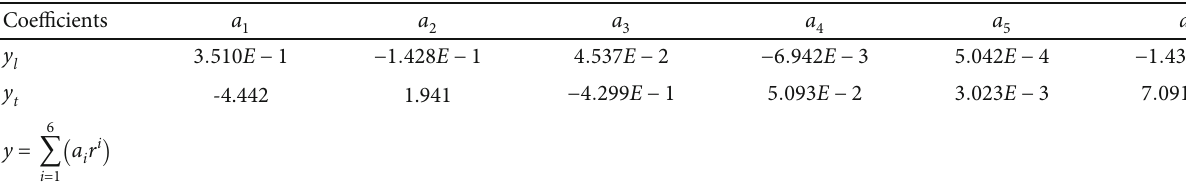
Table 1: The leading edge function and trailing edge function of the arti fi cial wing.